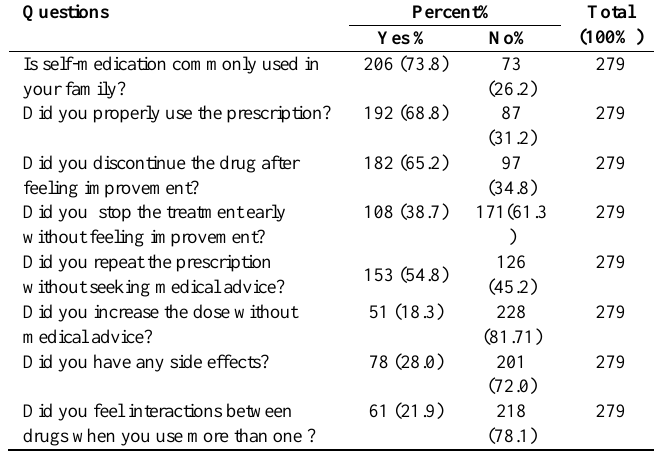
Table 6 : The behavior of the study population towards the use